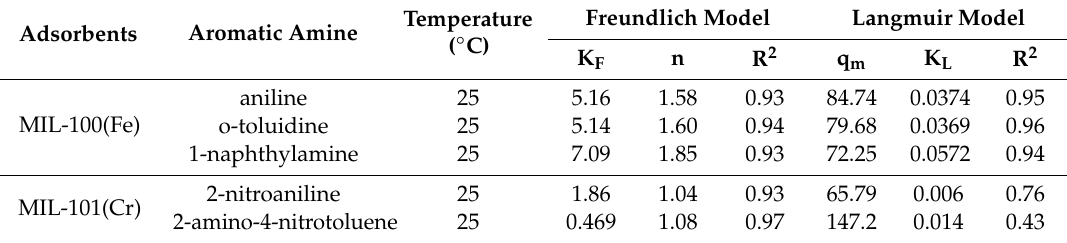
Table 2. Isothermal parameters of MIL-100(Fe), MIL-101(Cr) adsorption on aromatic amines. Freundlich Model Langmuir Model Temperature Adsorbents Aromatic Amine ( ◦ C) aniline